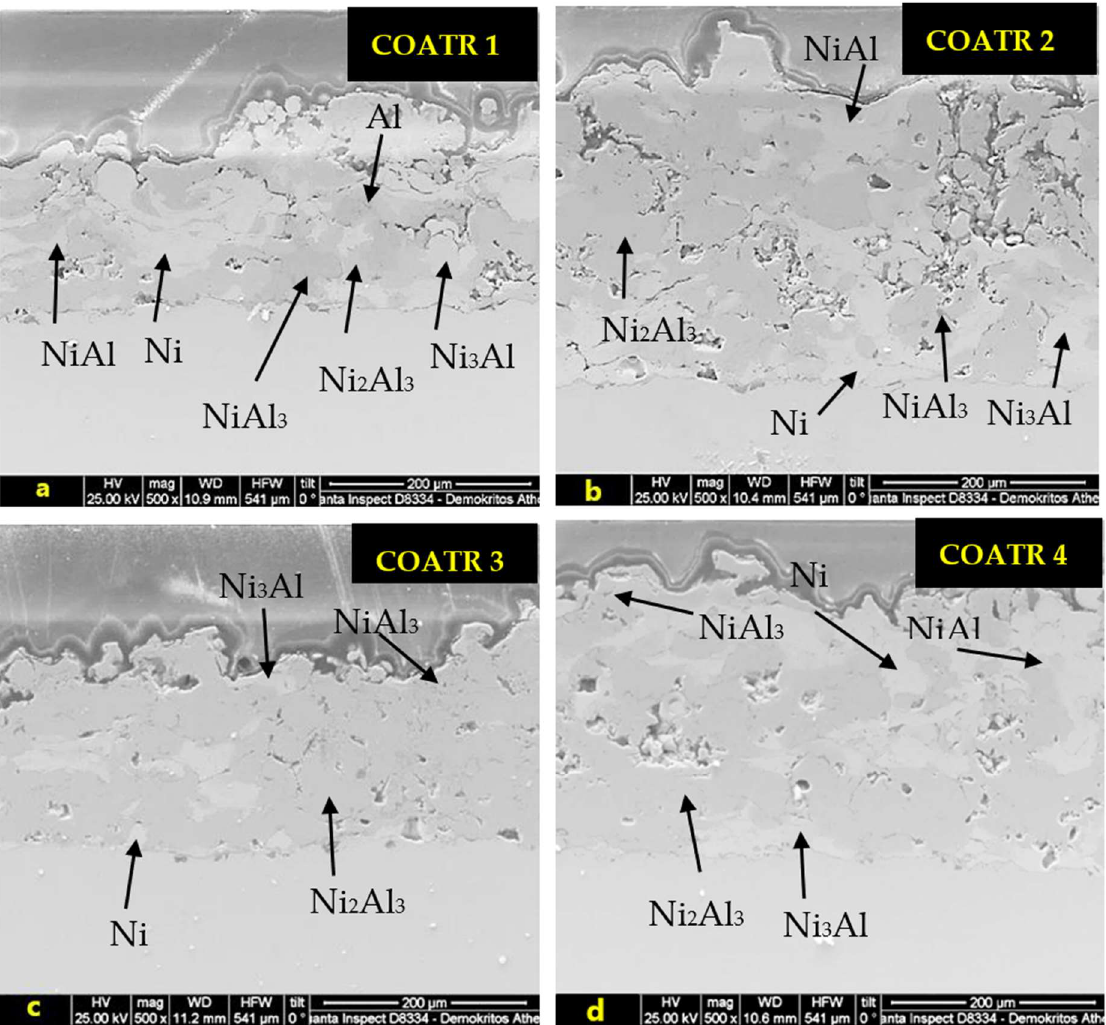
Figure 7. SEM (SE mode) micrographs of the coatings (in cross-section) at various levels of post- deposition heat treatment using the flame spraying gun; ( a ) 0 gun passes: COATR 1, ( b ) 10 gun passes: COATR 2, ( c ) 15 gun passes: COATR 3 and ( d ) 20 passes: COATR 4, corresponding to surface temperatures of about 400 °C, 500 °C, 600 °C and 700 °C, respectively. Based on data of [28].